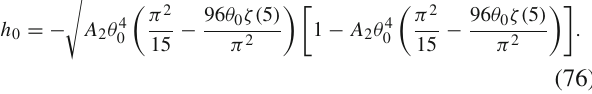
Fig. 4 Time evolution of the dimensionless temperature θ (left figure) and of the deceleration parameter q (right figure) in a loop quantum cosmological Universe filled with a deformed photon gas with the dis- persion relation E = kc ( 1 + λ E ) with λ k B T << 1, for different values of the parameter A 2 : A 2 = 10 7 (solid curve), A 2 = 2 × 10 7